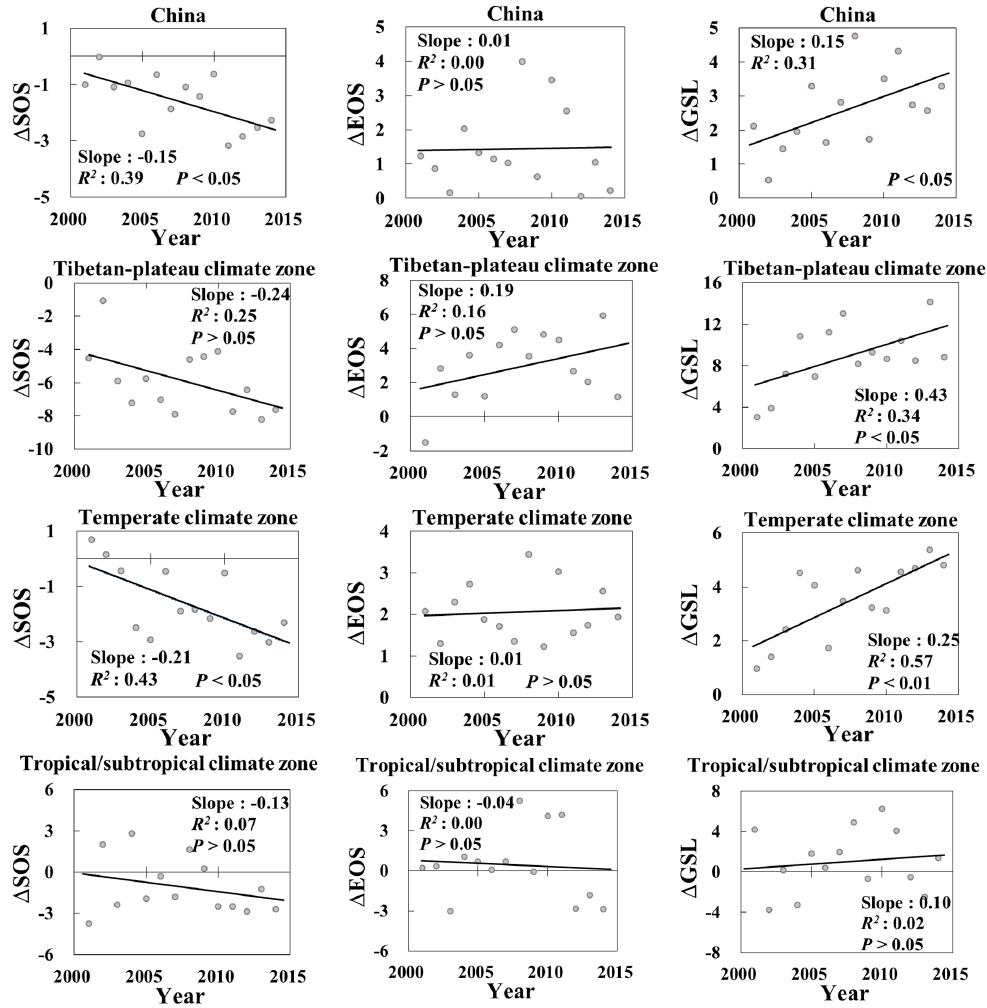
Figure 5. The trend of the phenological differences between the urban and rural areas from 2001 to 2014 (unit: day).